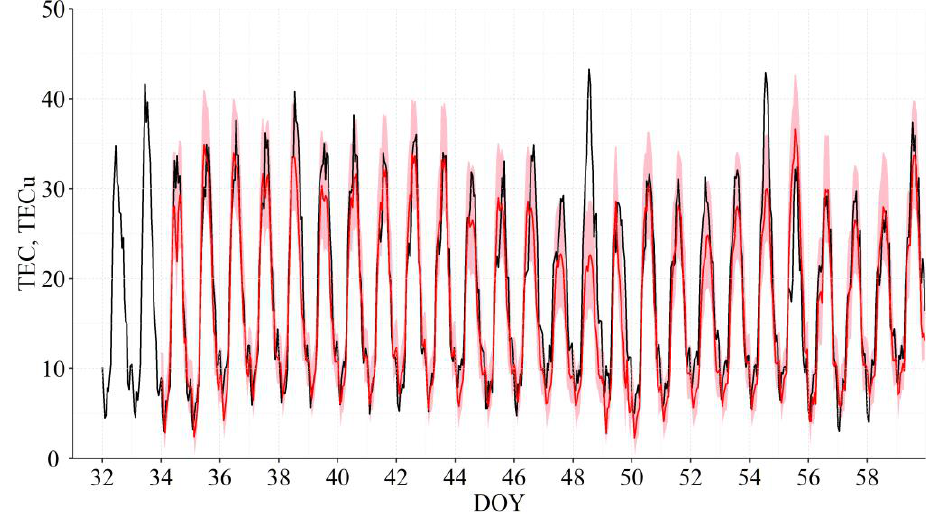
Figure 4. Observed (black) and forecasted using the PCA-MRM(L31, mean.lag1.2) model (red) 1h TEC series for June 2015; pink area shows 90% confidence interval (larger version can be found in SM, Figure S13).